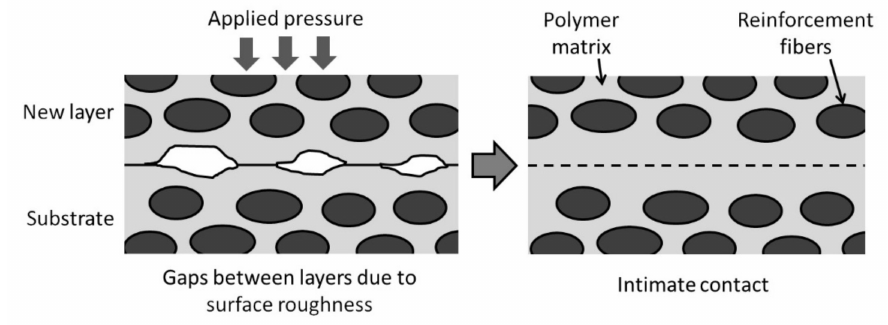
Figure 4. Establishing intimate contact at the interface between FRTP